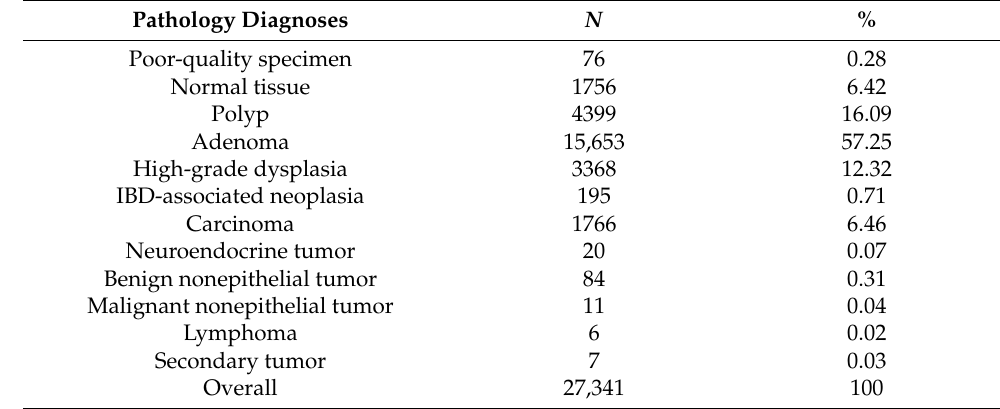
Table 3. Results of the pathological examination of the colorectal cancer screening program in Lithuania between 2014 and